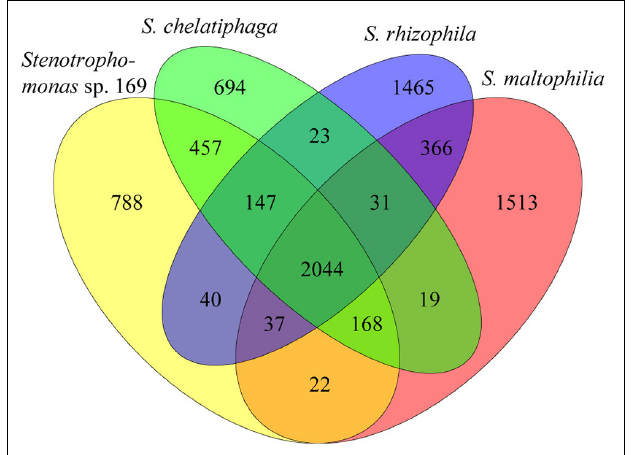
FIGURE 3 | Comparison of orthologous genes between the genomes of Stenotrophomonas sp. 169, S. chelatiphaga DSM 21508 T , S. rhizophila DSM 14405 T , and S. maltophilia R551-3. The number of shared and genome-specific genes is